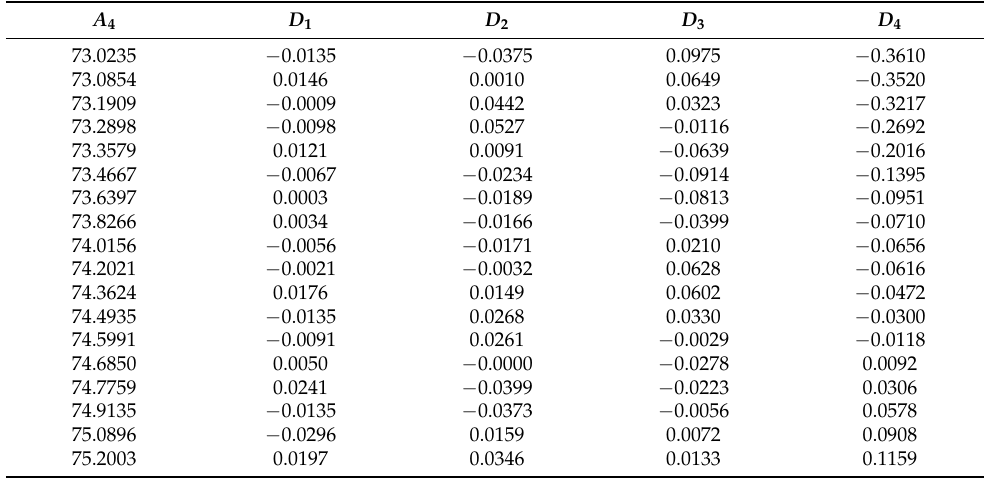
Table 9. Four-level wavelet decomposition of V 8 .